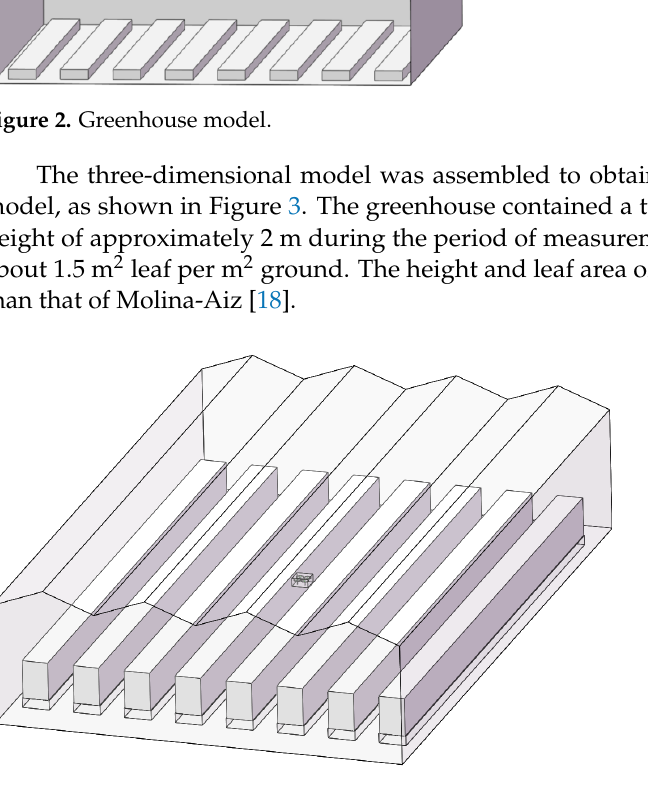
Figure 2. Greenhouse model.